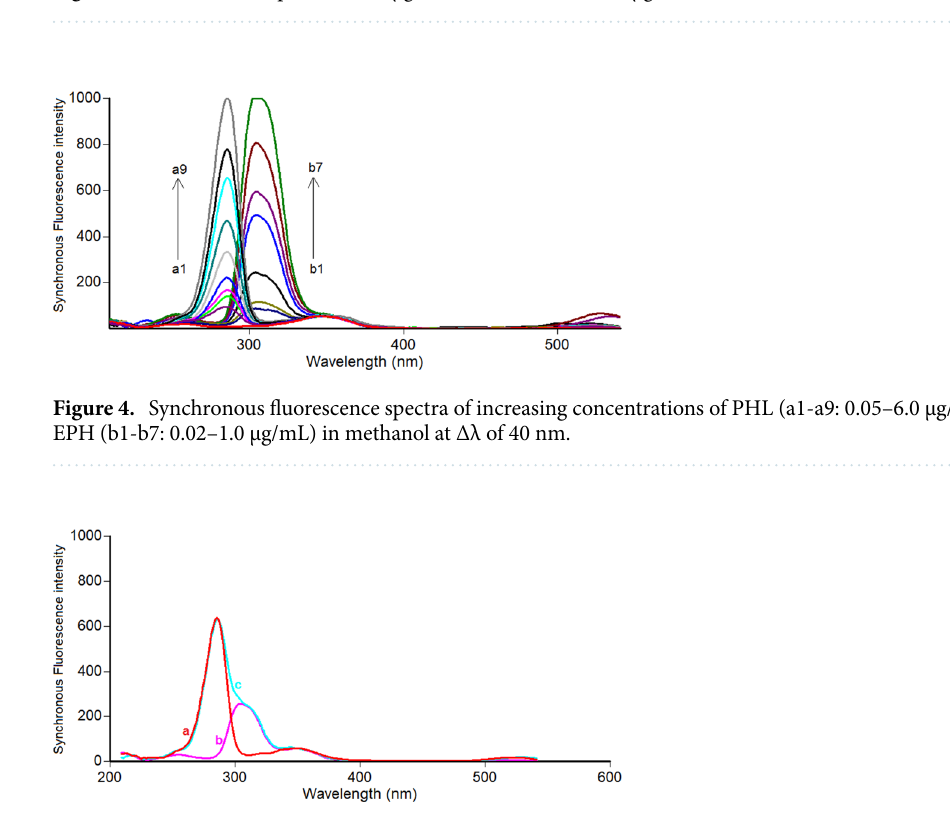
Figure 3. Fluorescence spectra of 1.2 μg/mL PHL (a, a*) and 0.2 μg/mL EPH (b, b*) in methanol.